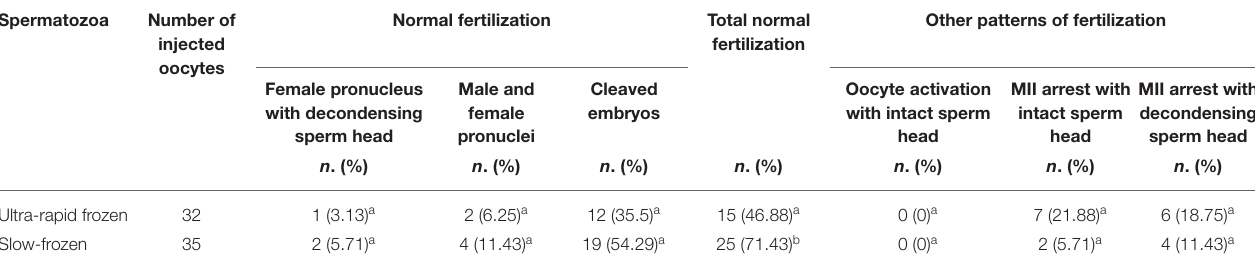
Classification according to Buarpung et al. (41). a , b Different superscripts indicate significant differences within columns (p ≤ 0.05). Data from 5 replicates. MII, metaphase II (mature)